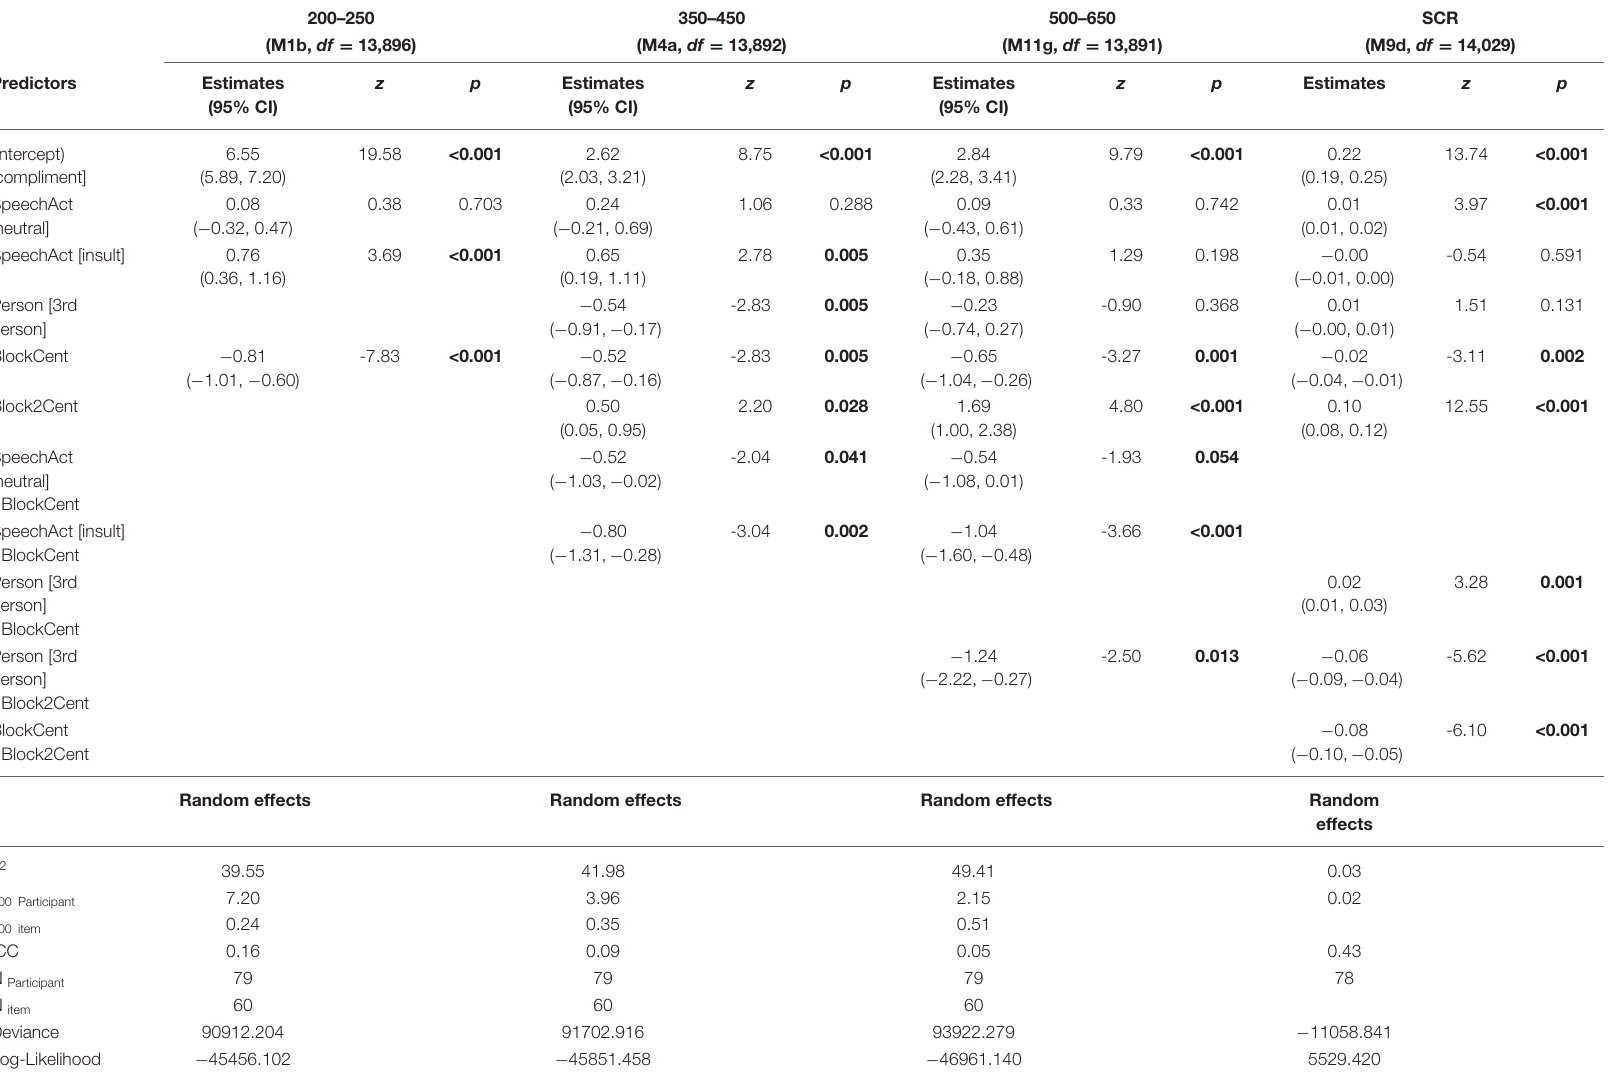
TABLE 1 | Linear mixed models analysis